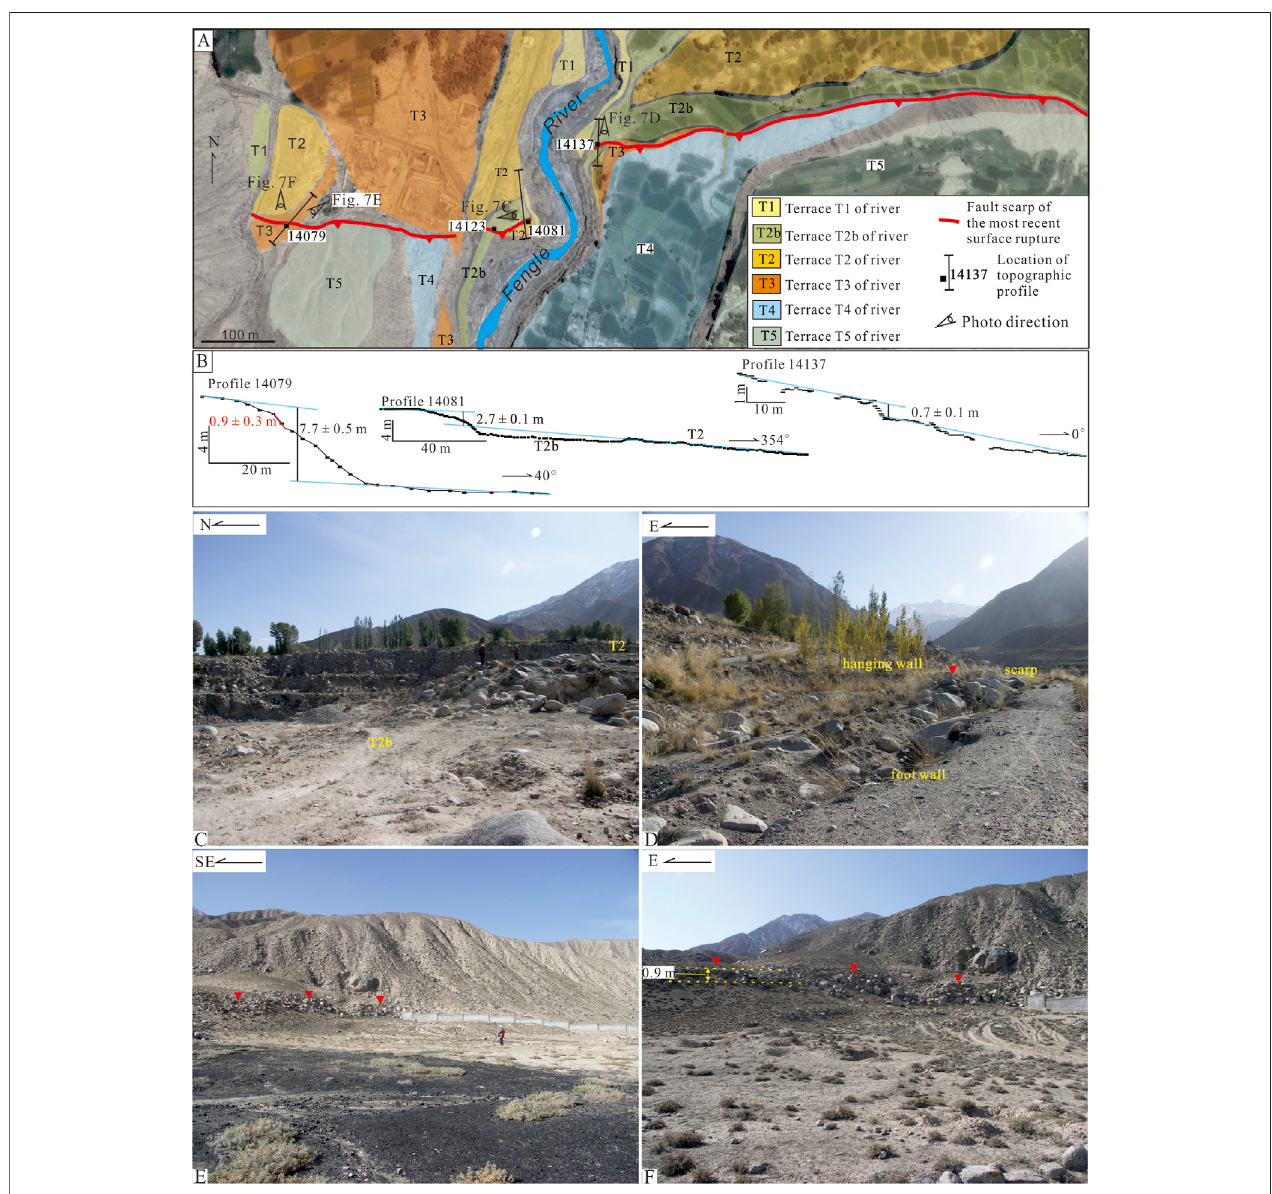
FIGURE 7 | Topographic features and photographs of the 1609 earthquake surface rupture at the Fengle River site. (A) Surface rupture map. (B) Topographic pro fi les across portions of 1609 rupture traces. (C) Gravels are outcropped on the fault scarp of T2 in the west river bank at point 14,081, and T2b is the late erosional surface on T2 with cobbles and gravels exposed. (D) A north-dipping scarp approximately 1.0 m high is present on T2b on the east river bank. (E,F) Free faces composed of boulders occur on high scarps of higher terraces on the west river bank, and the free face is approximately 0.9 m at point 14,079.